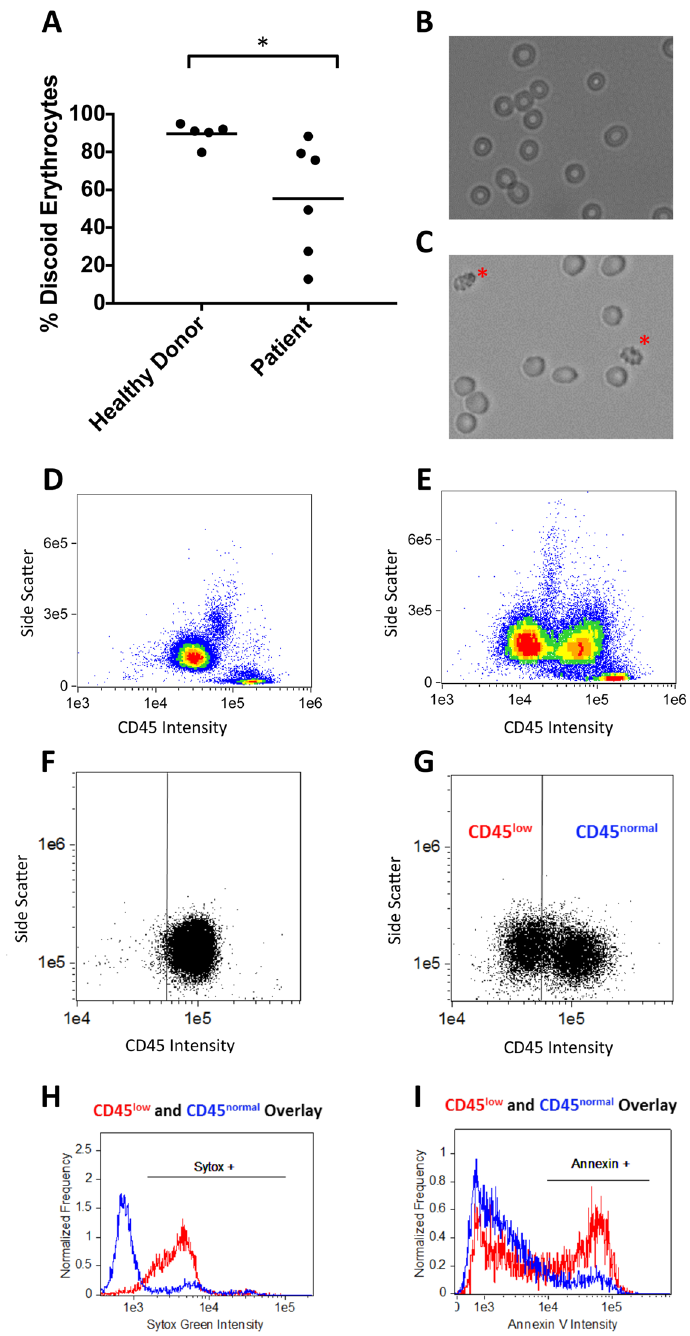
Figure 1. Degradation of whole blood components under ambient storage. Whole blood was collected from either healthy donors or metastatic cancer patients and stored under ambient conditions. Echinocytes were enumerated for each sample after 24 h storage. ( A ) Fewer echinocytes were observed in healthy donor samples (89.6 ± 5.8% discoid erythrocytes) compared to patient samples (55.5 ± 30.6% discoid erythrocytes, p < 0.05, t-test, values reported as mean ± standard deviation). ( B ) Images taken at 24 h show erythrocytes appear normal in the healthy donor blood sample compared to ( C ) image from patient sample where extensive echinocyte formation occurs (echinocytes noted with asterisk). ( D ) CD45 v Side Scatter plot reveals the expected distribution of leukocytes in a freshly collected blood sample compared to ( E ) the leukocytes collected from whole blood following 72 h ambient storage, where a new population of leukocytes with reduced CD45 expression was observed. ( F – I ) To study leukocyte degradation more closely in a simplified manner, neutrophils were isolated from fresh healthy donor blood and stored in culture media followed by analysis by flow cytometry. ( F ) CD45 expression in fresh neutrophils compared to ( G ) 72 h neutrophils shows this population undergoes extensive degradation. The CD45 low neutrophil population was shown to contain a greater number of ( H ) dead and ( I ) apoptotic cells compared to the CD45 normal